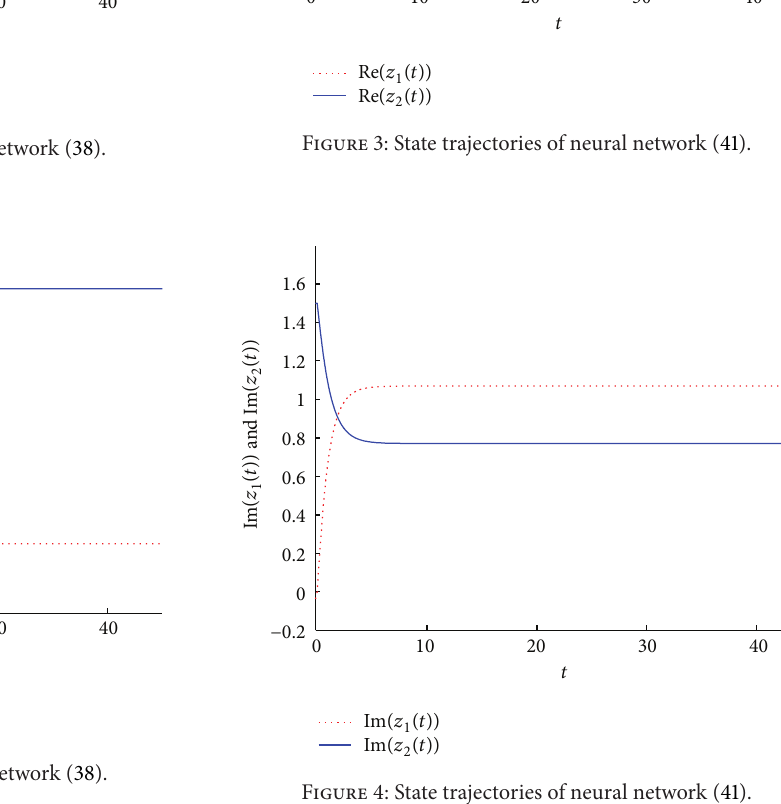
Figure 4: State trajectories of neural network